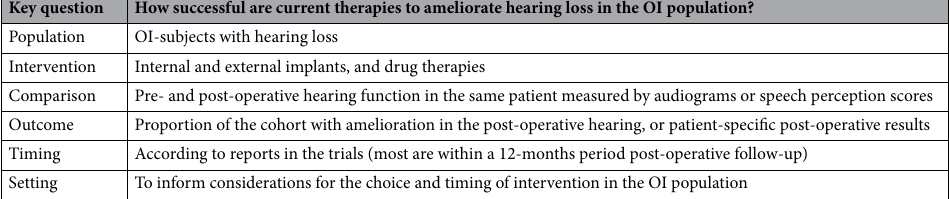
Table 1. Population, intervention, comparison, outcome, timing and setting (PICOTS) of the therapies to ameliorate hearing loss in osteogenesis imperfecta